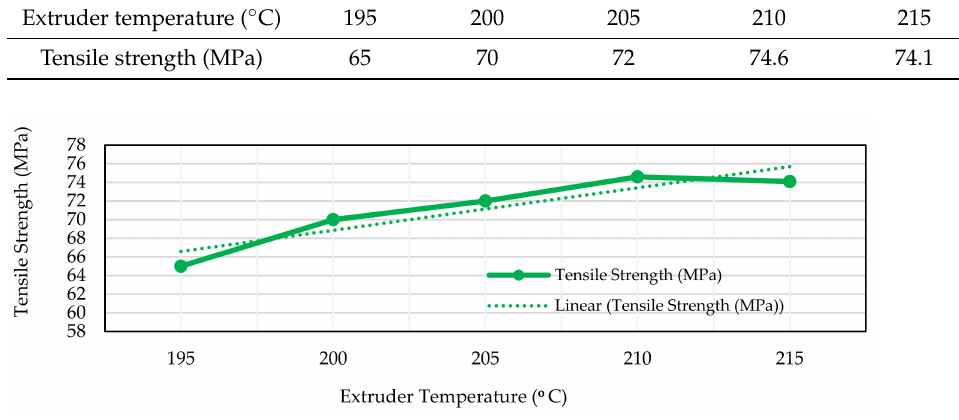
Figure 9. Tensile strength vs. extruder temperature.